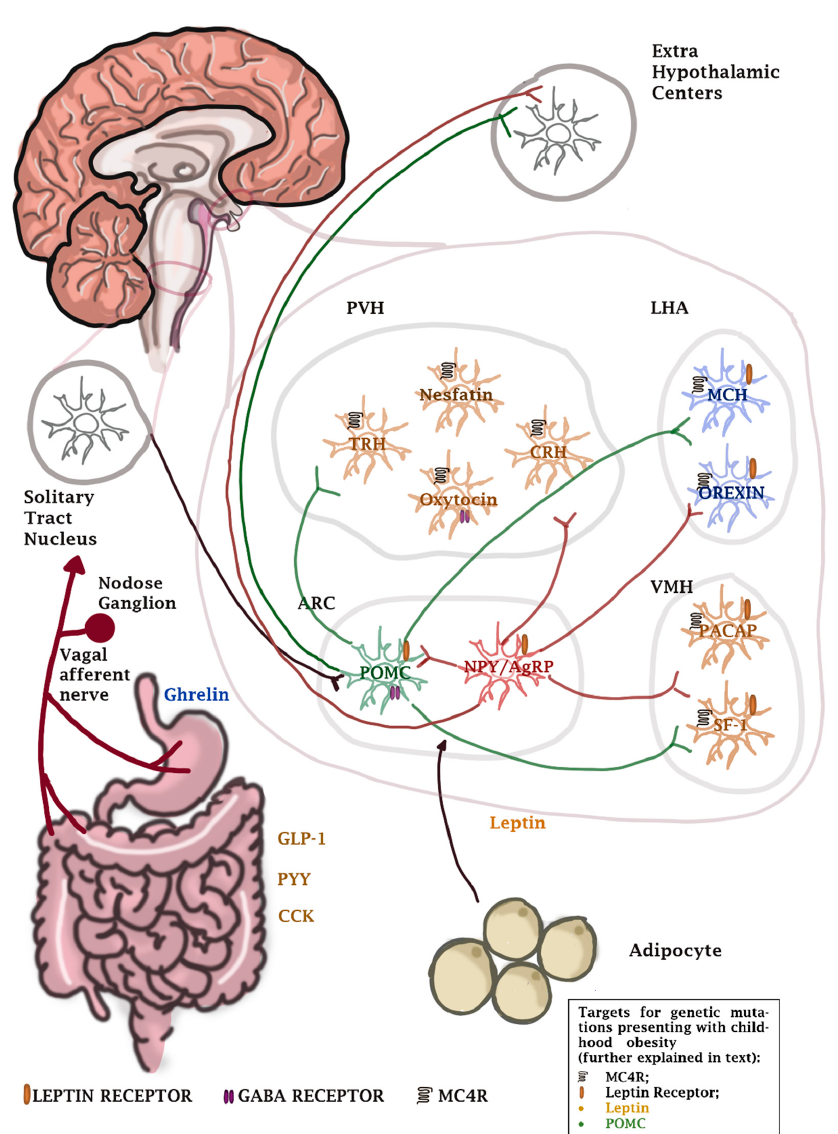
Figure 12. Neurohormonal regulation of appetite [153]. Pro-opiomelanocortin (POMC) neurons in the arcuate nucleus (ARC) suppress appetite by means of secreting a-melanocyte-stimulating hormone (a-MSH) which acts upon melanocortin 4 receptors (MC4R) exhibited by neurons in the paraventricular nucleus (PVH), ventromedial nucleus (VMH), lateral hypothalamic area (LHA), dorsomedial nucleus, and several other non-hypothalamic brain regions. Neuropeptide Y (NPY)/agouti-related peptide (AgRP) neurons have an opposite effect and stimulate hunger by acting upon the NPY receptor and by antagonizing the action of a-MSH on MC4R. In addition, AgRP also acts upon the Kir 7.1 potassium channel and induces the hyperpolarization of MC4R-expressing neurons. By projecting both stimulatory and inhibitory appetite signals in the same areas, the neurons within ARC serve as key modulators in this respect, depending on which particular neuron population is activated predominantly. Furthermore, NPY/AgRP neurons inhibit POMC neurons by interacting with the GABA receptor, thus prioritizing the generation of hunger sensation over suppressing it. Leptin secreted by adipocytes acts upon the arcuate nucleus by passing through the blood–brain barrier, while peptides produced by the gastrointestinal tract use the vagus nerve to interact with the hypothalamus. The effects of these peptides on appetite are further detailed in text (Sections 6.1.2 and 6.1.3). Red lines represent inhibitory pathways, while green ones represent stimulatory ones. Hormones and peptides with blue text have an overall effect of stimulating appetite, while those with orange text have an inhibitory effect in this respect. Genetic mutations presenting with obesity in childhood include congenital leptin deficiency, the hypothalamic receptor for leptin mutations, alteration of POMC-aMSH pathway, and loss of function mutations of MC4R receptors [154,155]. Further detailed in Section